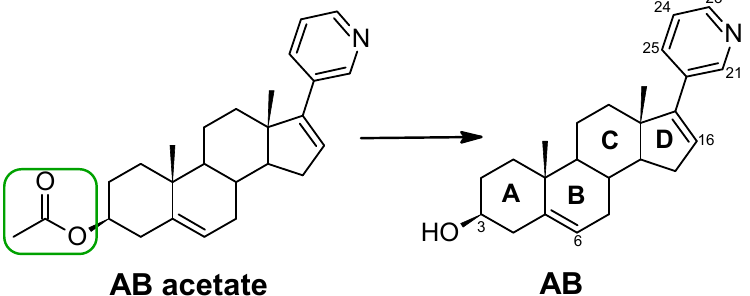
Figure 1. Structures of abiraterone acetate (AB acetate) and abiraterone (AB). Four rings of the androsta-5,16-dien-3 β -ol moiety are denoted as A, B, C, and D.